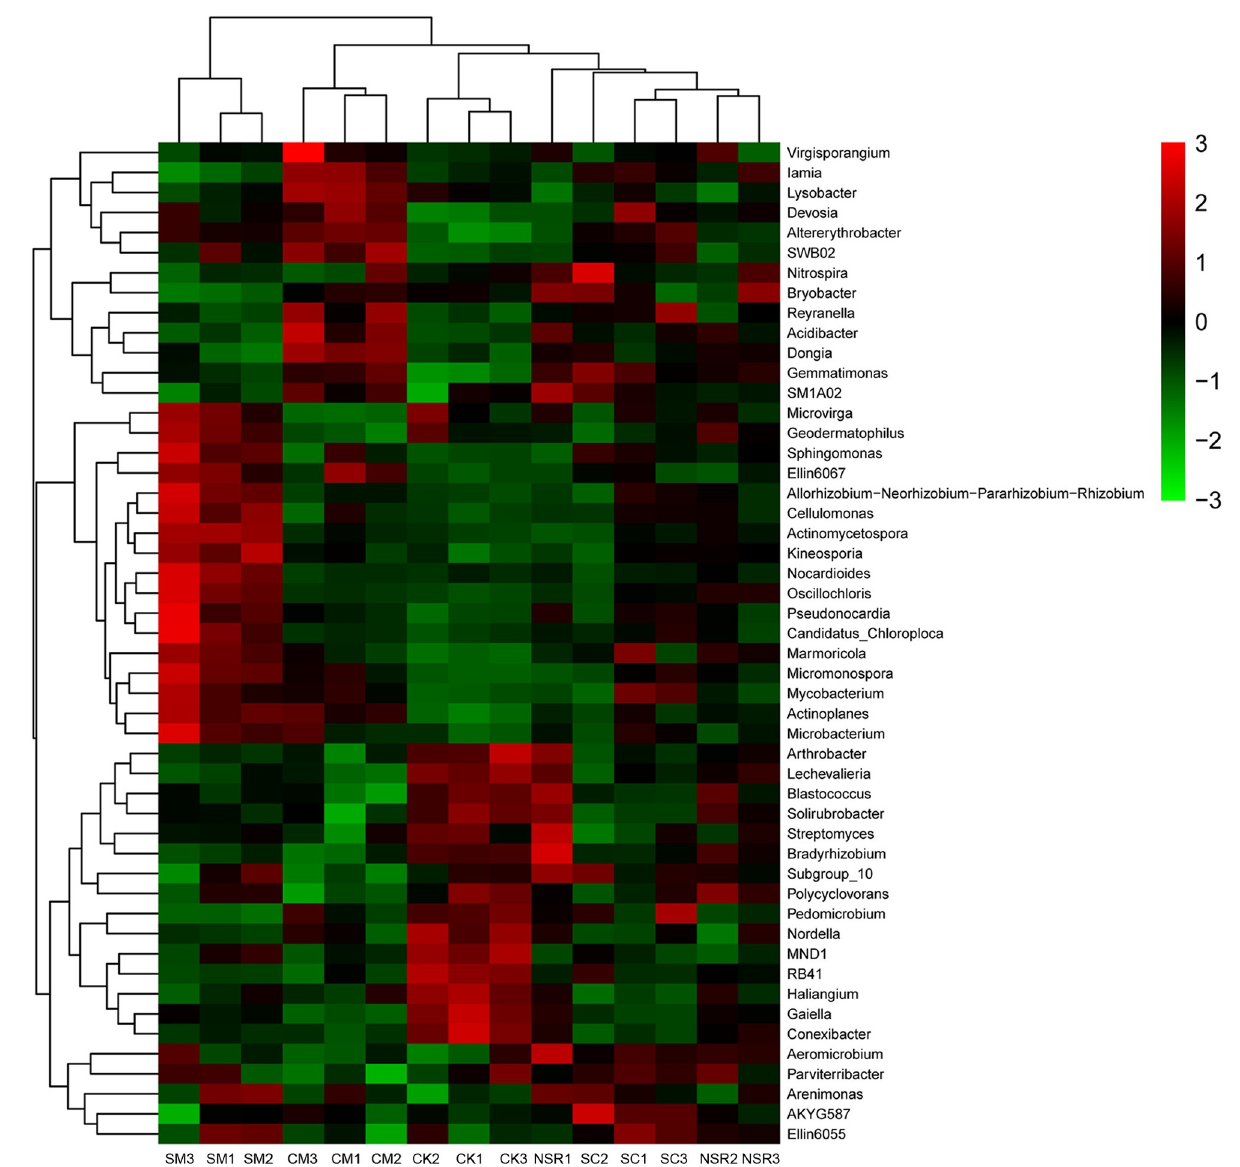
Fig 5. Hierarchically clustered heat map analysis of community composition in the soil samples under different